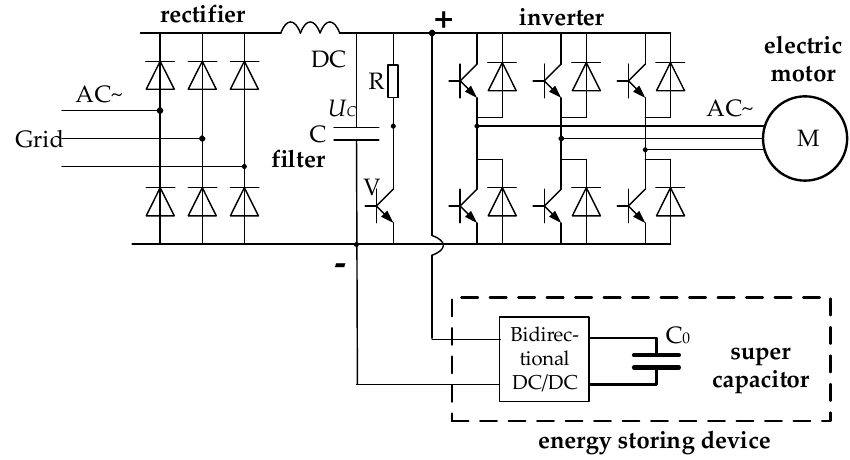
Figure 1. The inverter main circuit and energy storage for the energy-efficient method.